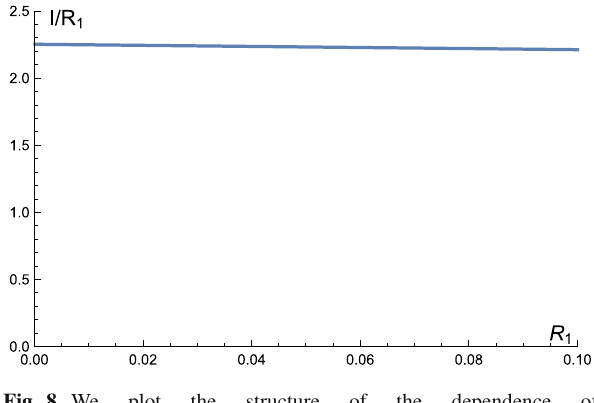
Fig. 8 We plot the structure of the dependence of , R , R , R )/ R I ( R G C 0 1 1 as a function of R 1 for small values of this